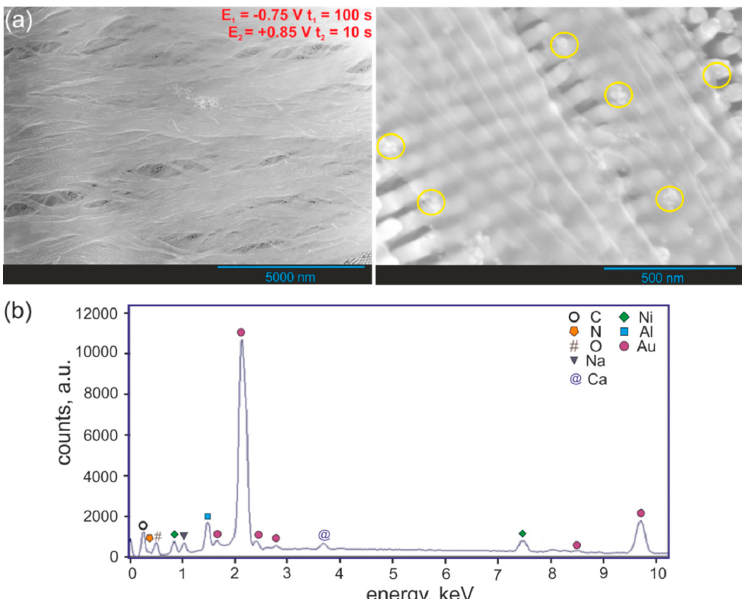
Figure 3. Low magnification (left-hand side) and high magnification (right-hand side) FE-SEM images of the PPy-Ni(OH) 2 nanowire array ( a ) together with EDS analysis of hybrid nanowires ( b ). The presence of Ni(OH) 2 nanoparticles is marked with yellow